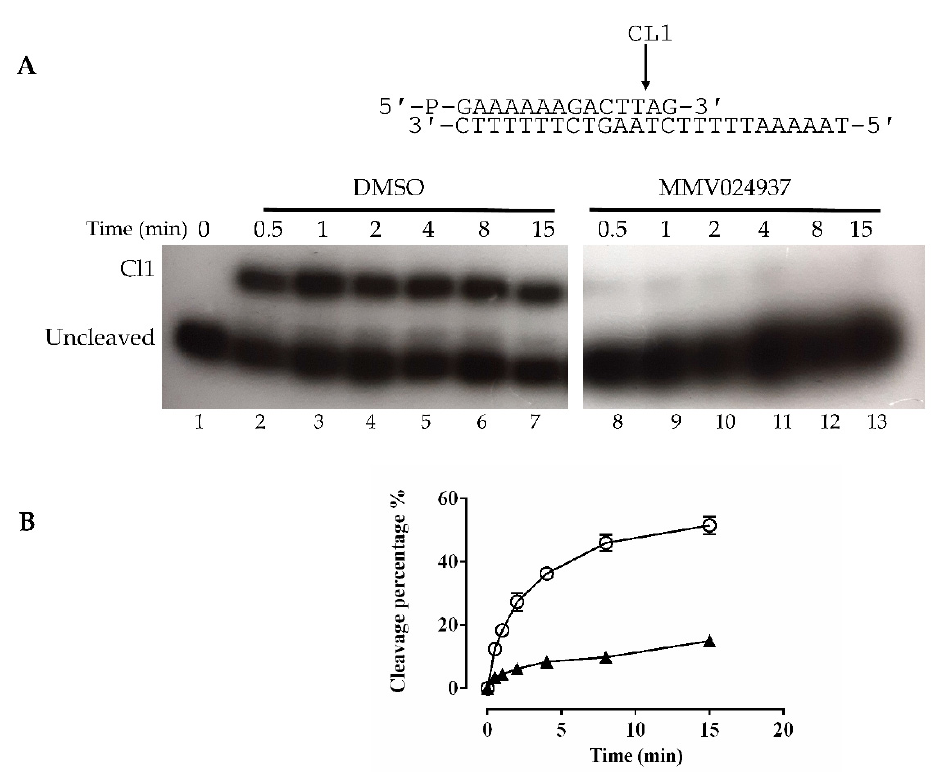
Figure 3. Cleavage kinetics. ( A ) Cleavage reaction of the enzyme with the CL14/CP25 suicide substrate, shown at the top of the figure, in a time course experiment in the presence of only DMSO (lanes 2–7), or MMV024937 dissolved in DMSO (lanes 8–13). In lane 1 the protein was not added. CL1 represents the DNA strand cleaved by the enzymes at the preferred cleavage site, indicated by an arrow. ( B ) Percentage of cleaved suicide substrate, normalized to the total amount of each lane, plotted against time for the reaction with only DMSO (circles) and MMV024937 dissolved in DMSO (triangles). Data are means ± SD obtained from three independent experiments.